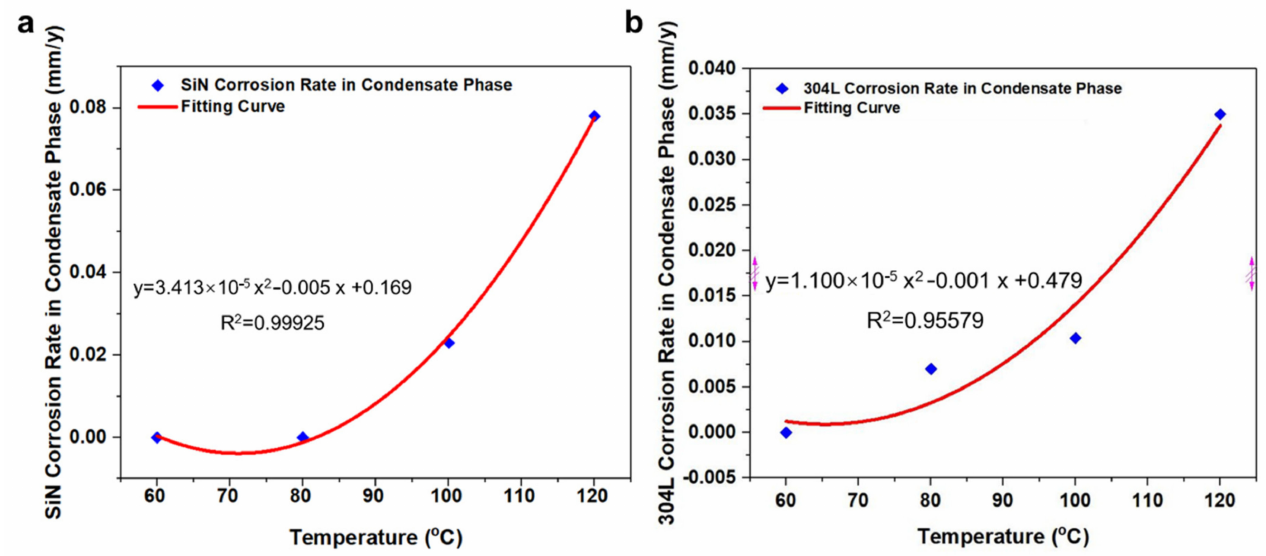
Figure 13. Corrosion rate fitting curves of SiN and 304L stainless steels in nitric acid condensate phase at different temperatures, ( a ) SiN stainless steel and ( b ) 304L stainless